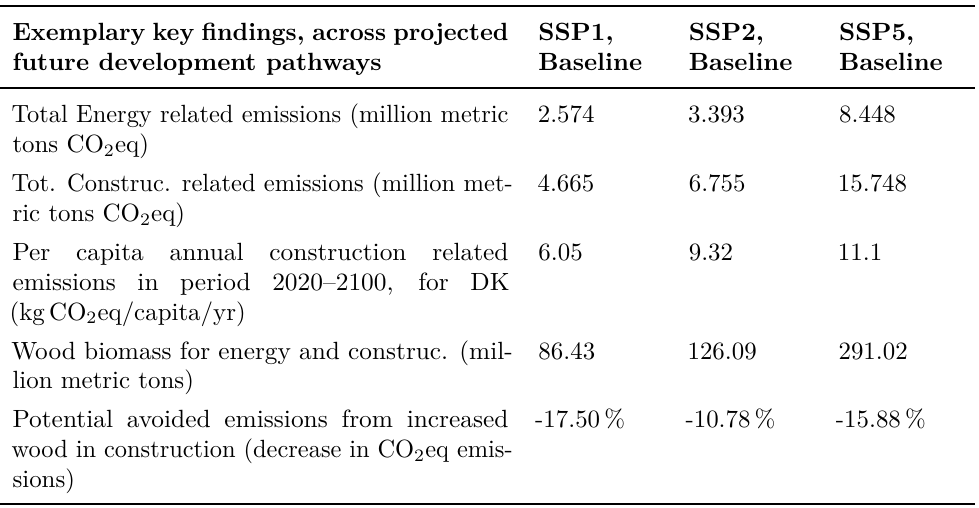
Table 4. Exemplary findings from applying the different future narratives, to the case study. The case study is executed on country